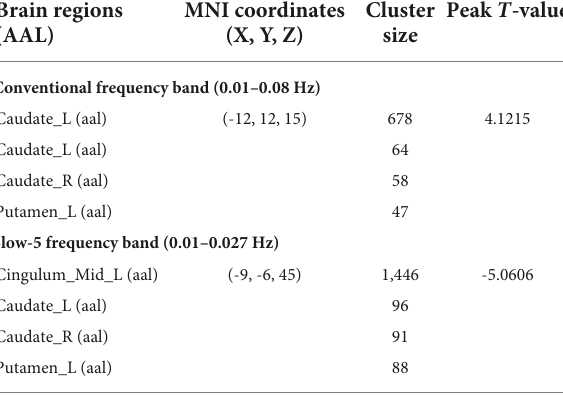
TABLE 2 Brain regions with significant differences in ReHo in three different frequency bands between ReHo in BGIS and HCs groups. Brain regions MNI coordinates Cluster Peak T -value (AAL) (X, Y, Z) size